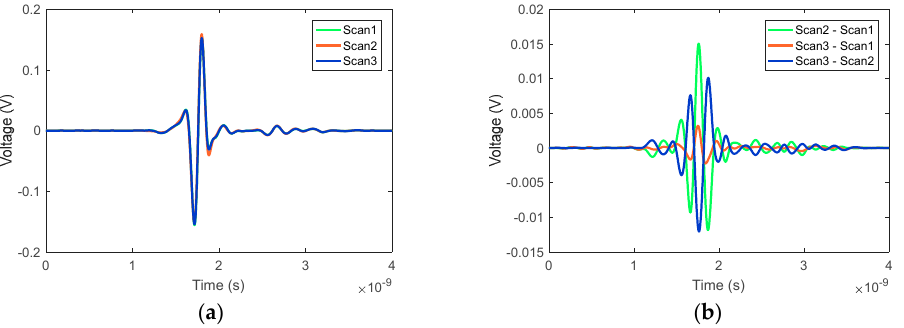
Figure 10. Calibrated (antenna response removed) signals recorded at the same location (position 127) for the three consecutive scans, showing the highest residual difference between scans. ( a ) Time domain signals for the three scans and ( b ) differences between scans.